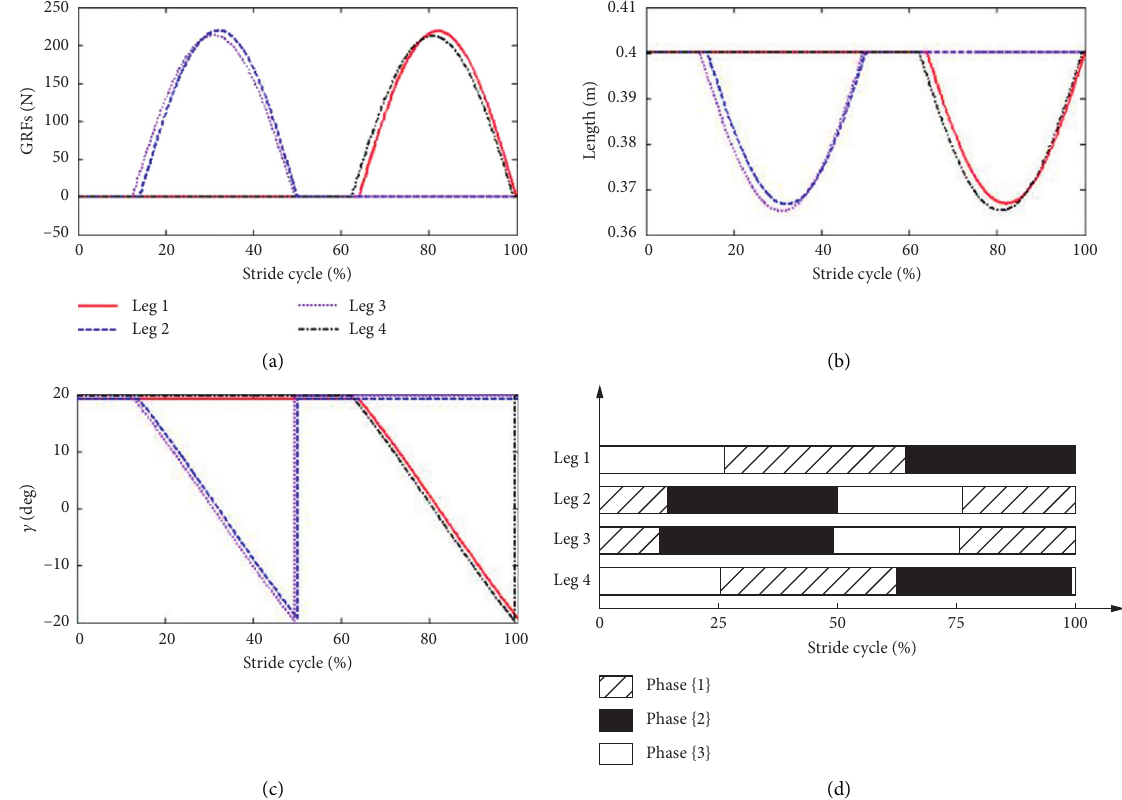
Figure 5: Leg behavior and gait sequence at 2.44m/s. (a) Ground reaction forces of four legs, (b) length change of four springy legs, (c) elevation angle of four legs, and (d) gait feature.